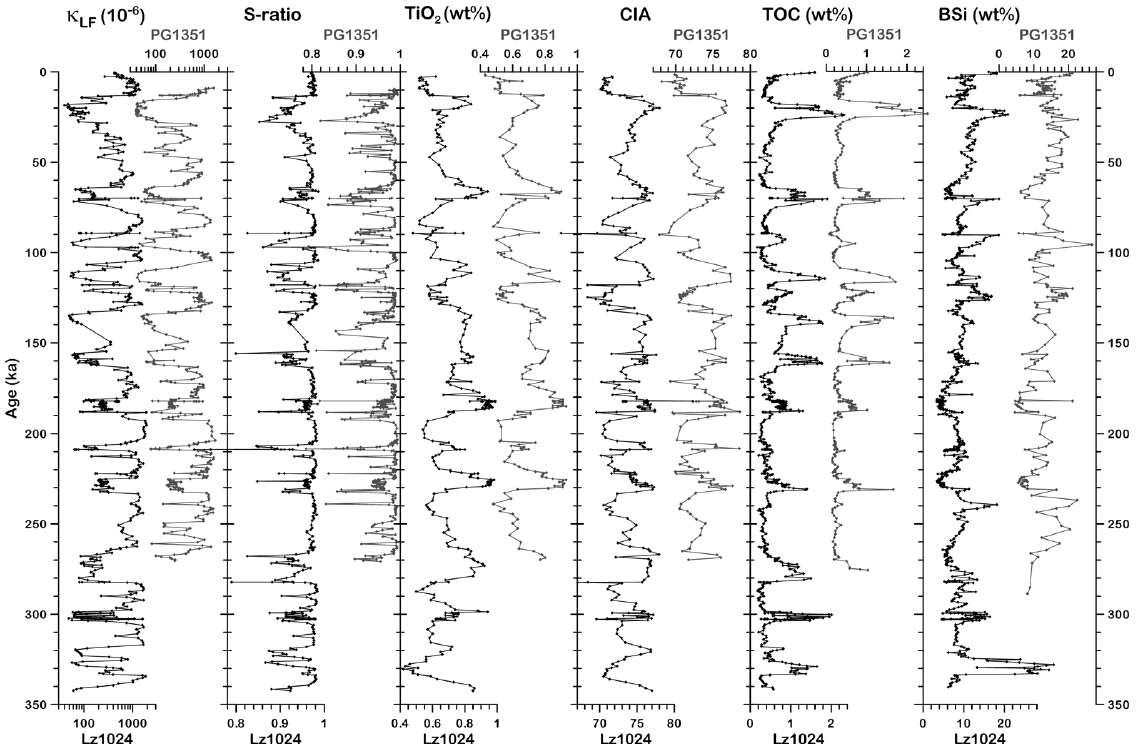
Fig. 3. Comparison of the records of magnetic susceptibility ( κ LF ) , S-ratio, TiO 2 content, chemical index of alteration (CIA), total organic carbon (TOC) content, and content of biogenic silicium (BSi) for cores PG1351 and Lz1024 from Lake El’gygytgyn. All records are plotted versus